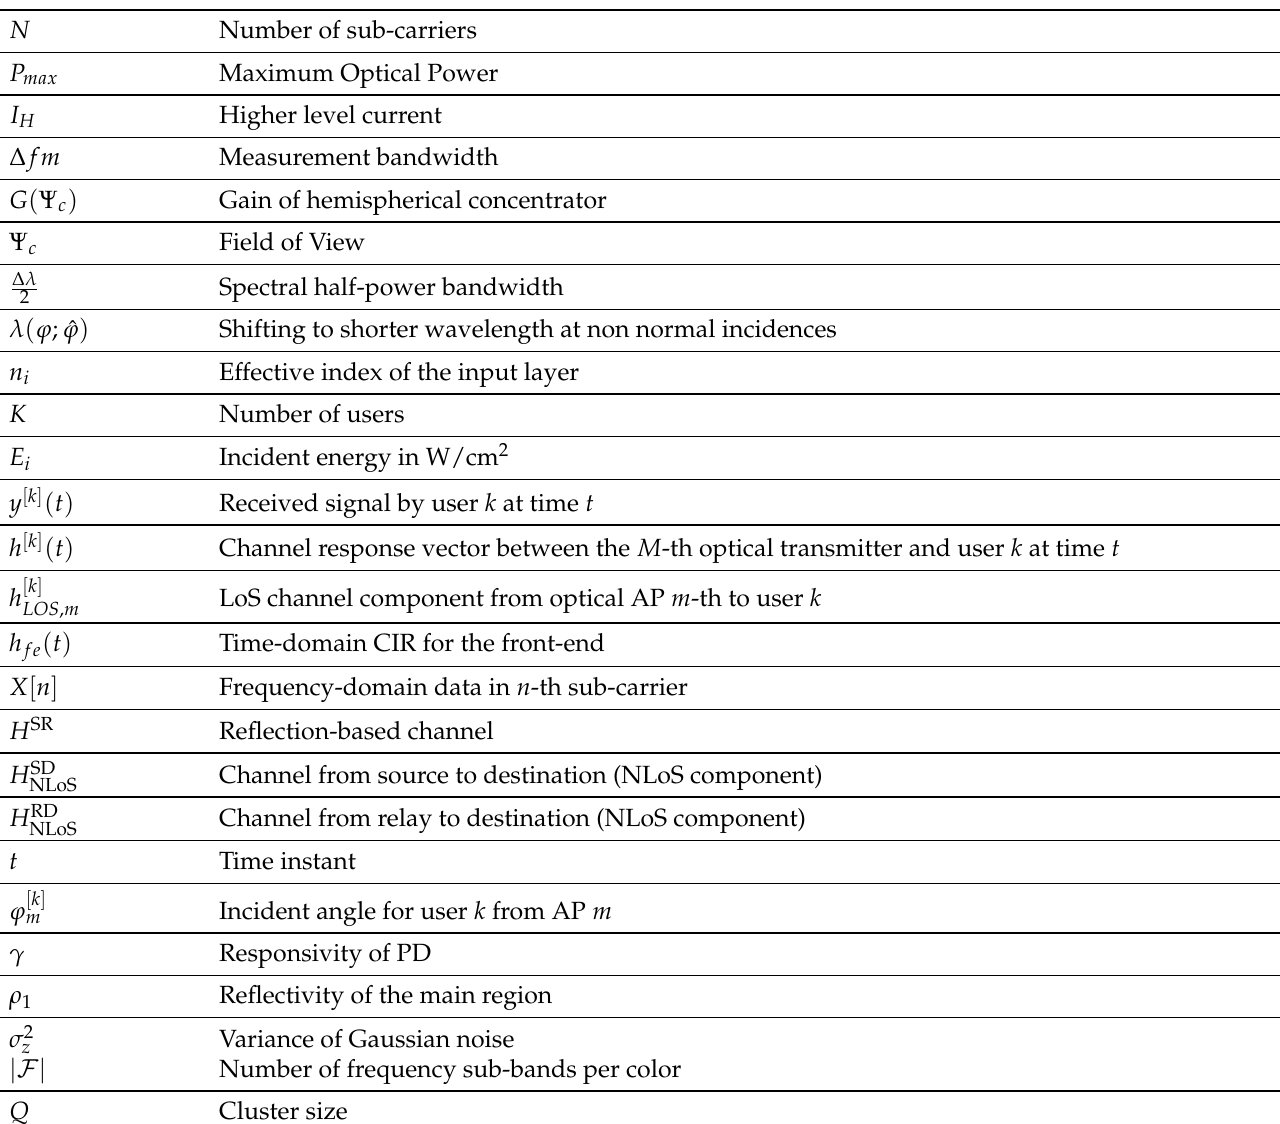
Table 2. List of variables in this